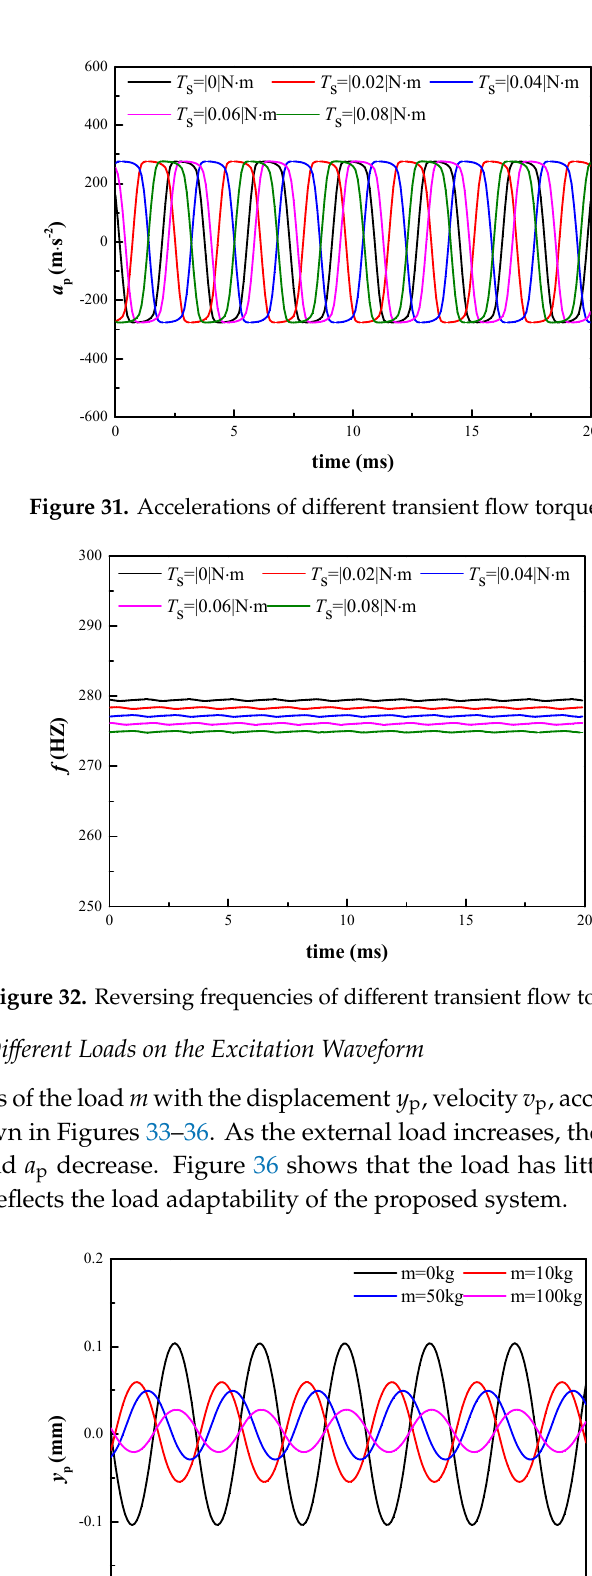
Figure 30. Velocities of different transient flow torques.